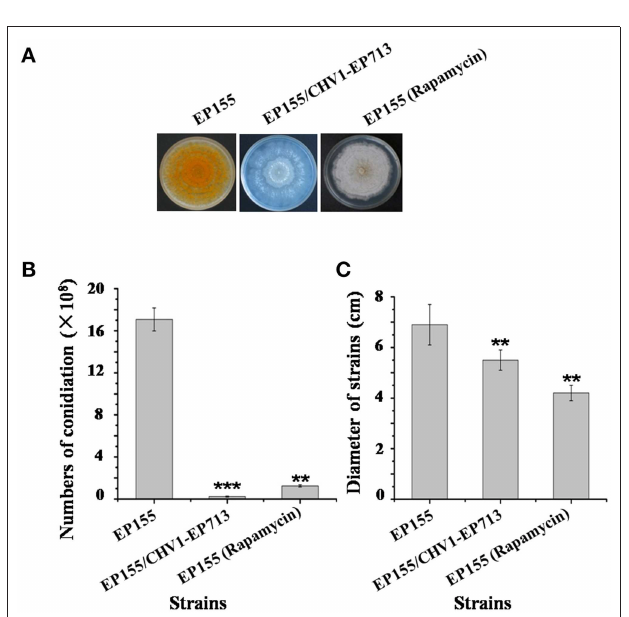
FIGURE 2 | Sporulation level and growth rates of hypovirus infection and rapamycin treatment on C. parasitica. (A) Phenotypes on PDA. Photo was taken at day 7. (B) Sporulation level. Spores were counted on day 14. (C) Growth rates of EP155, EP155/CHV1-EP713, and EP155 (rapamycin treatment, 60nM) Growth rate was measured from cultures grown on PDA for 7 days. Values are means ± S.E.M of three independent experiments. ** indicates P < 0.01 and *** indicates P < 0.001, determined by Student’s t -test.